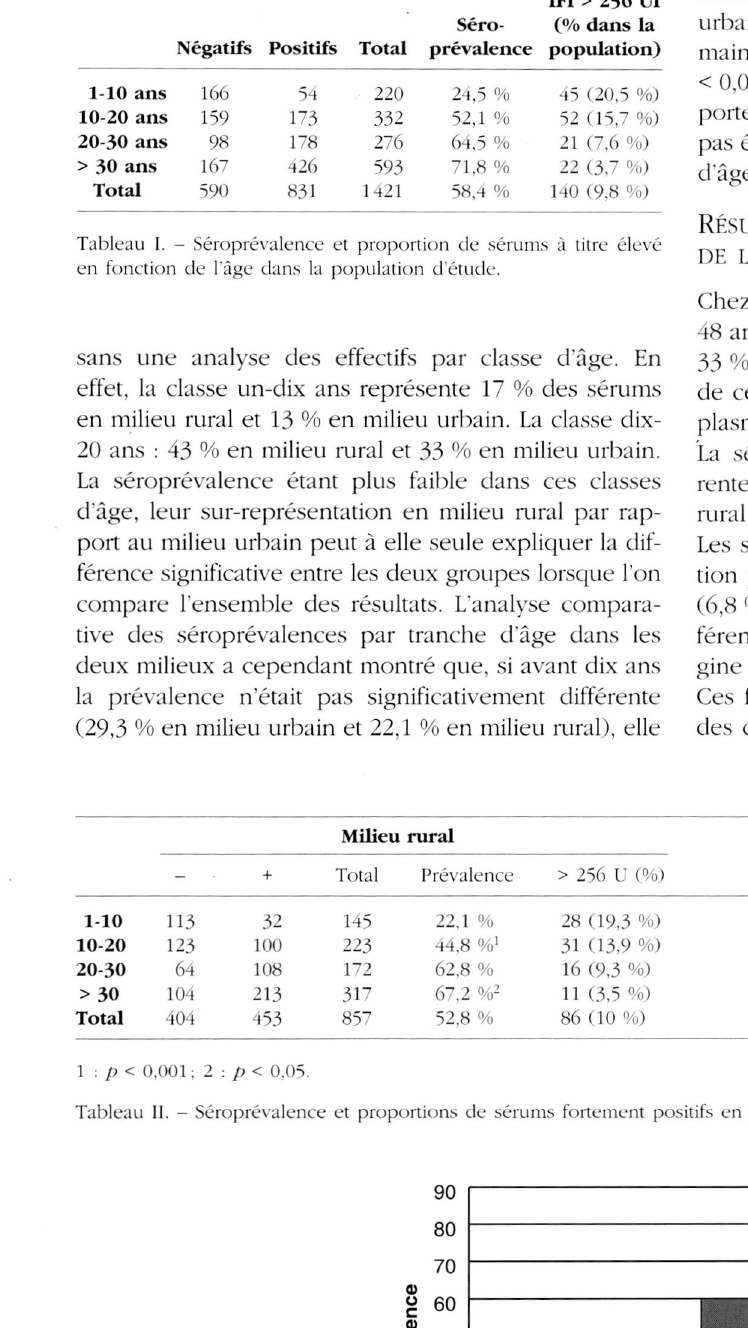
Fig. 1. - Séroprévalence dans la population générale.